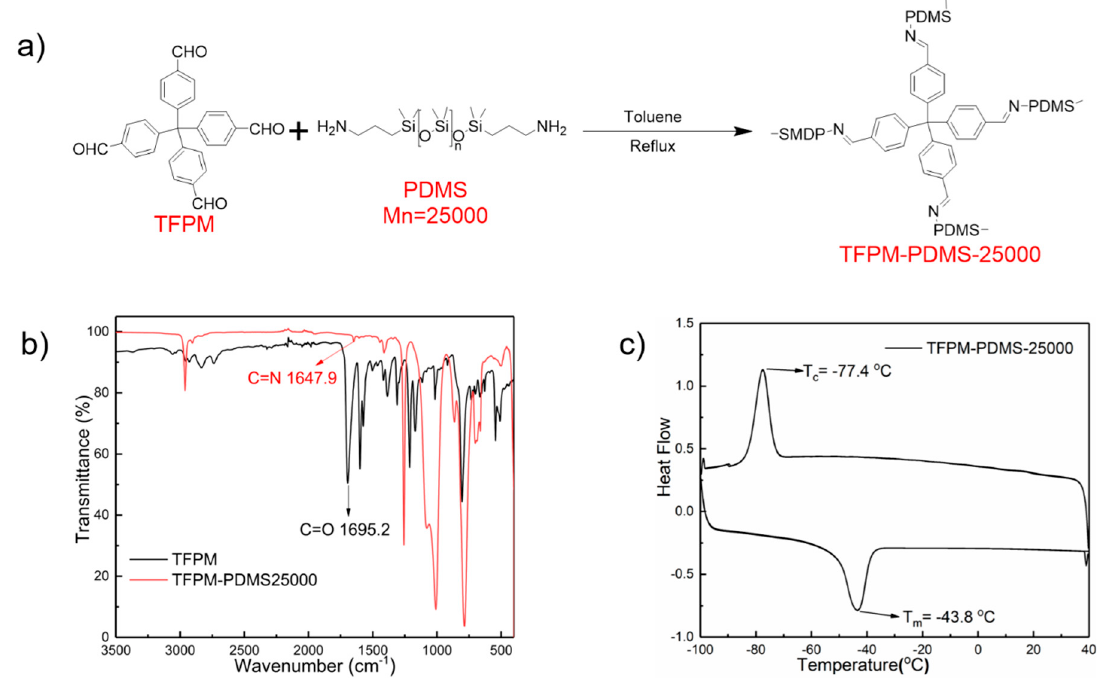
Figure 1. ( a ) Synthesis route of TFPM-PDMS-25000 polymer. ( b ) FTIR spectra of TFPM (4-[tris(4-formylphenyl)methyl]benzaldehyde) and TFPM-PDMS-25000. ( c ) The differential scanning calorimetry (DSC) curve of TFPM-PDMS-25000 polymer.